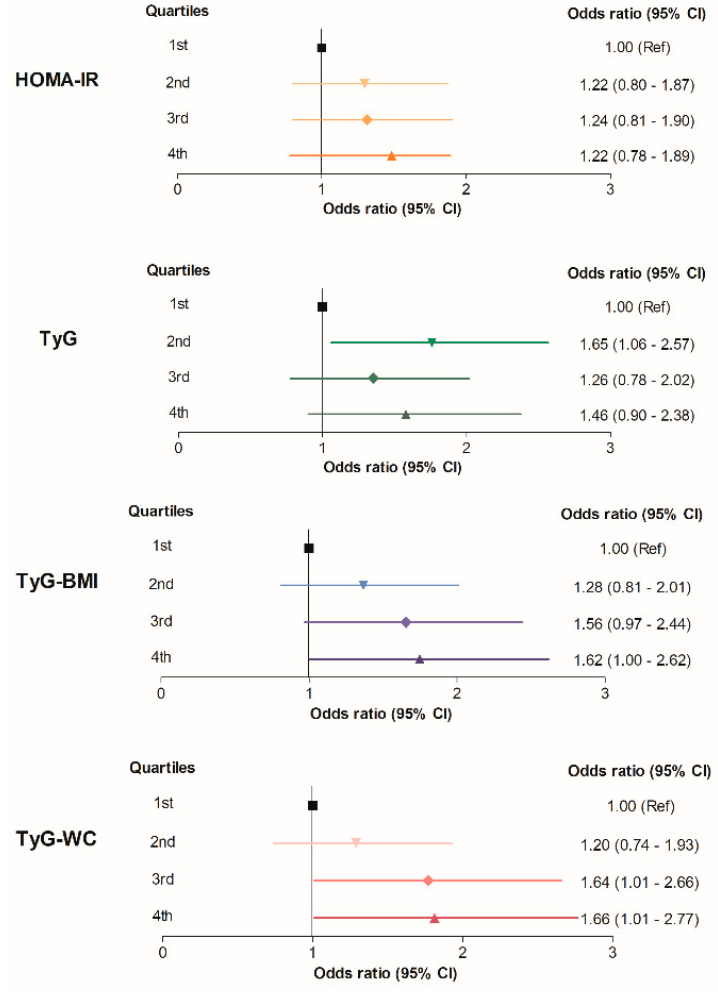
Figure 4. Summarized figure for CAC progression risk according to the quartiles of each parameter in the final cohort including non-progressors and progressors ( n = 1145). The ORs (95% CIs) are adjusted for age, sex, systolic BP, LDL-C, HDL-C, smoking, drinking, exercise habits, baseline CAC score, and follow-up interval.